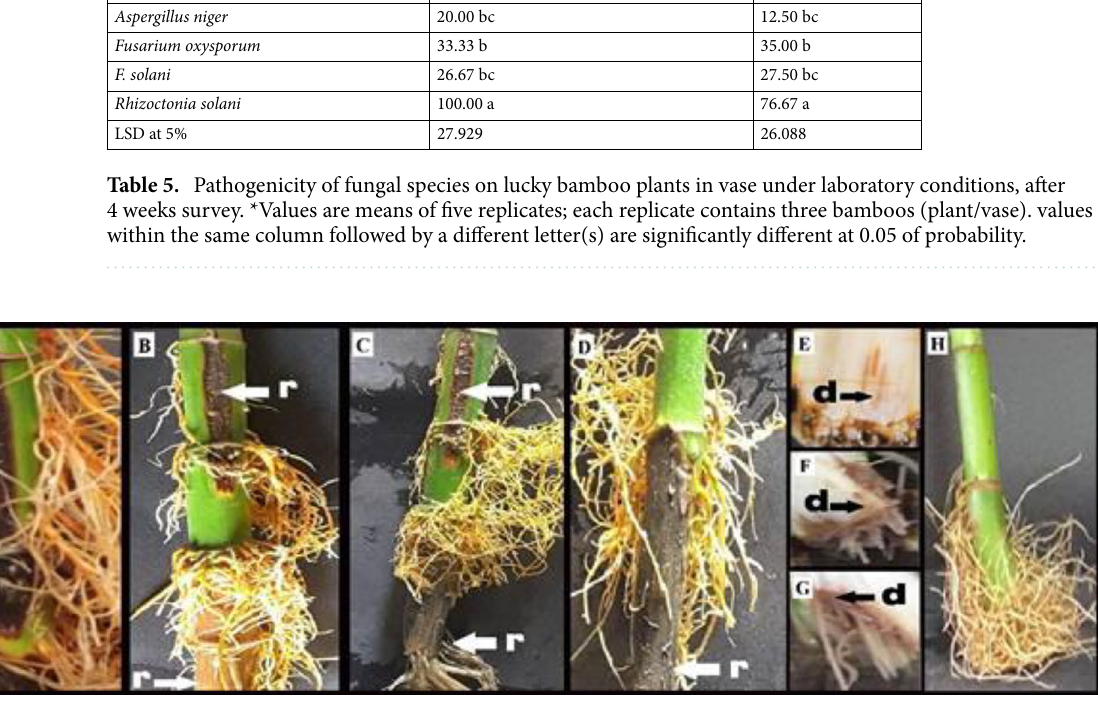
Figure 3. Symptoms of basal stem rot, root rot at natural and artificial infestation caused by Rhizoctonia solani during pathogenicity test of lucky bamboo ( D. sanderiana hort. ex. Mast.) in vitro, ( A ) naturally infected, and ( B , C & D ) symptoms of dieback of the rotting basal stem party after artificial infected (r) rotting brown discoloration at the middle of the basal stem, ( E , F , and G ) longitudinal sections of the basal stem, (d) internal brown discoloration of the basal stem’s, and ( H ) uninfected